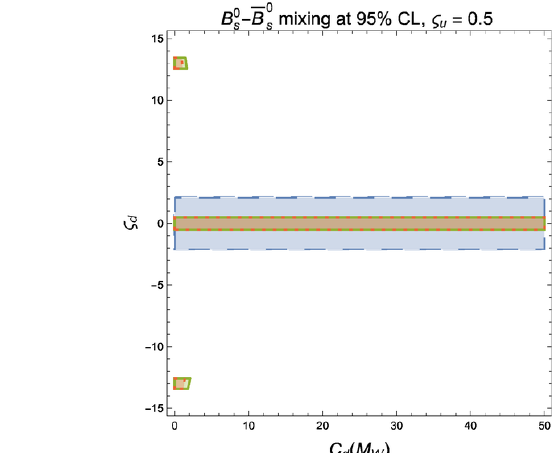
- (cid:22) B 0 mixing constraints on C d ( M W ) and & u ( & d ) for a s s